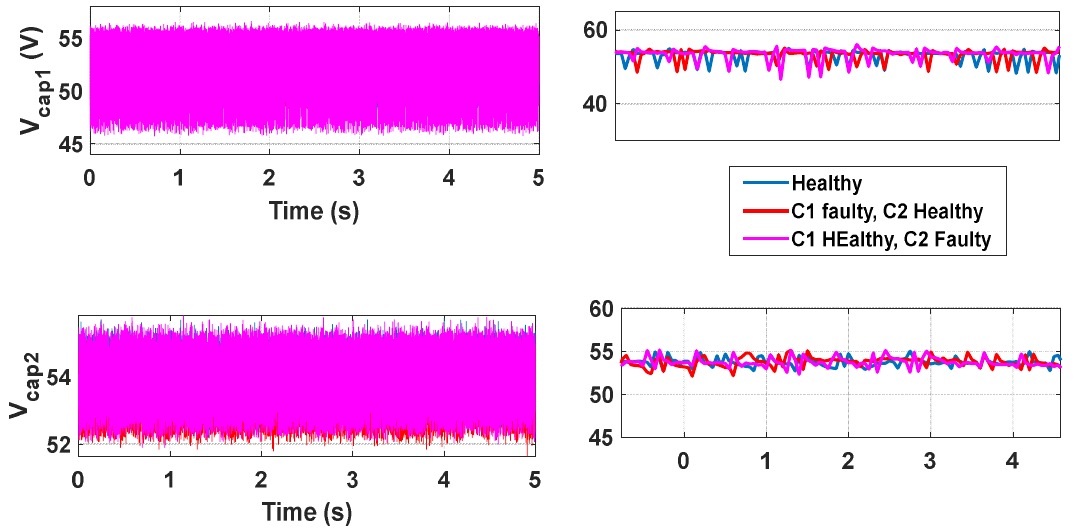
Figure 10. Cap1 and Cap2 voltage in healthy and faulty states.